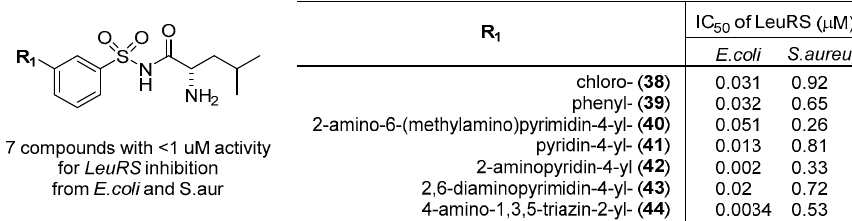
Scheme 1. Synthesis of N -aminoacyl-arylsulfonamides.